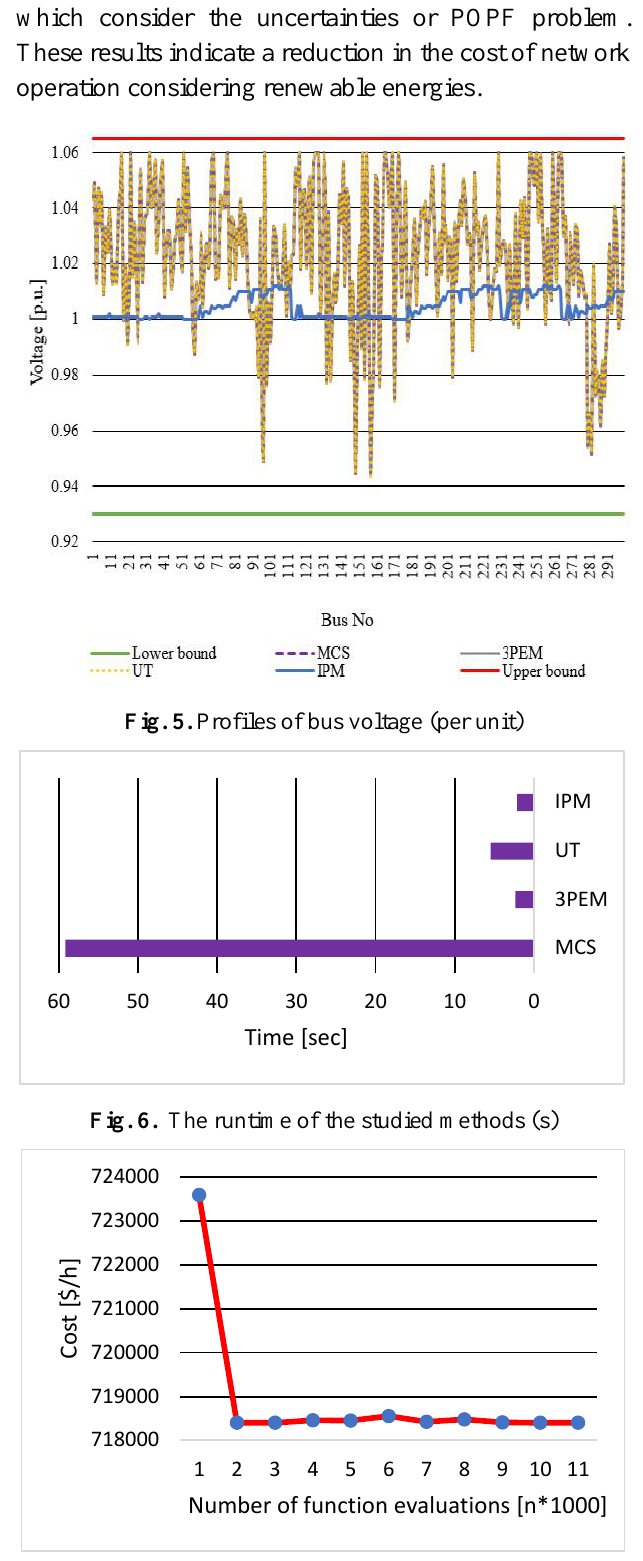
Fig. 7. Convergence curve Monte Carlo simulation method